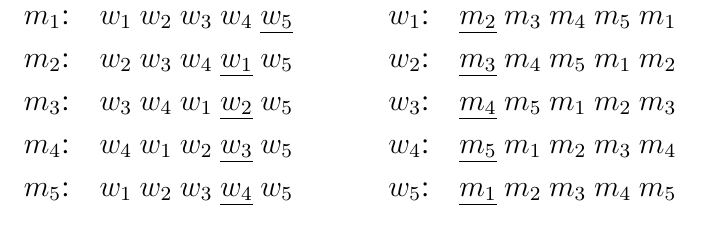
Figure 1. Worst case example for the Gale–Shapley algorithm for n = 5 . Partners in the man-optimal stable matching are underlined. Each preference list is ordered from left to right in increasing order of the rank, i.e ., the leftmost person is the most preferable and the rightmost person is the least